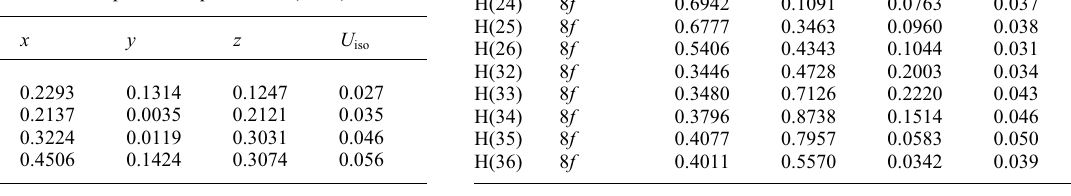
Table 2. Atomic coordinates and displacement parameters (in Å 2 ) .